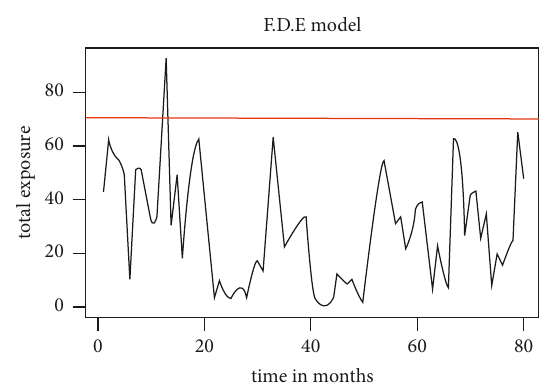
Figure 2: A trajectory of the exposure process to a contaminant through time θ �